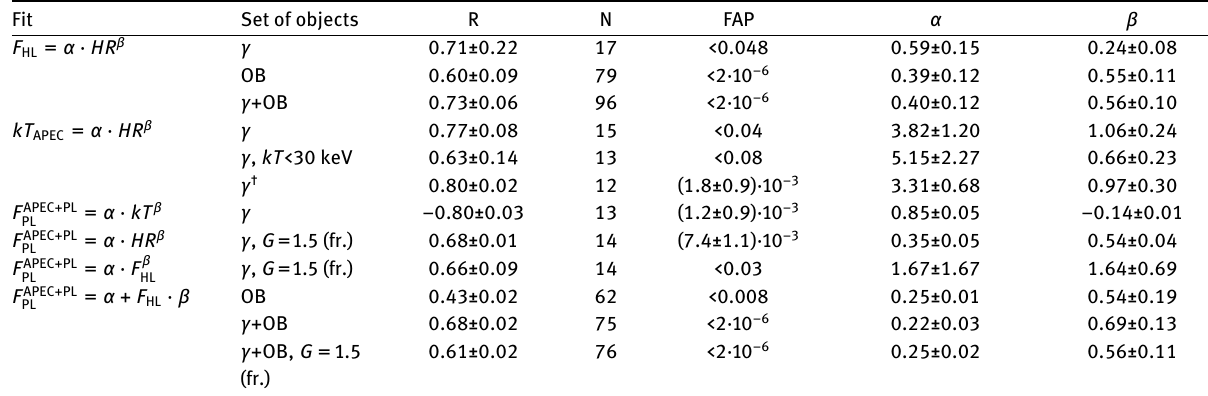
Table 8. The results of fitting the dependences between different characteristics of X-rays from γ Cas analogues (set γ in the table) and typical OB stars (set OB). For set γ † we exclude 3 objects of the temperature with the greatest